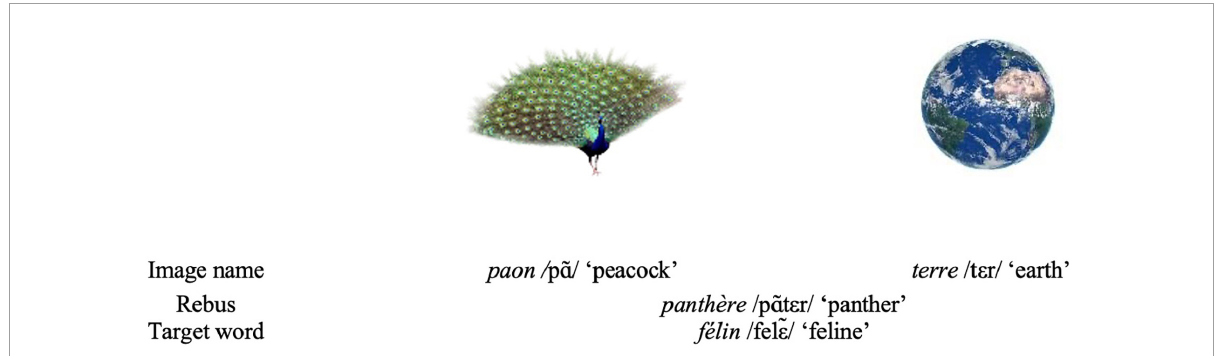
FIGURE2 Example of an experimental stimulus composed of the target word félin “feline” and the images of paon /pã/ “peacock” and the image of terre /t ε r/ “earth”; composing the French rebus panthère /pãt ε r/